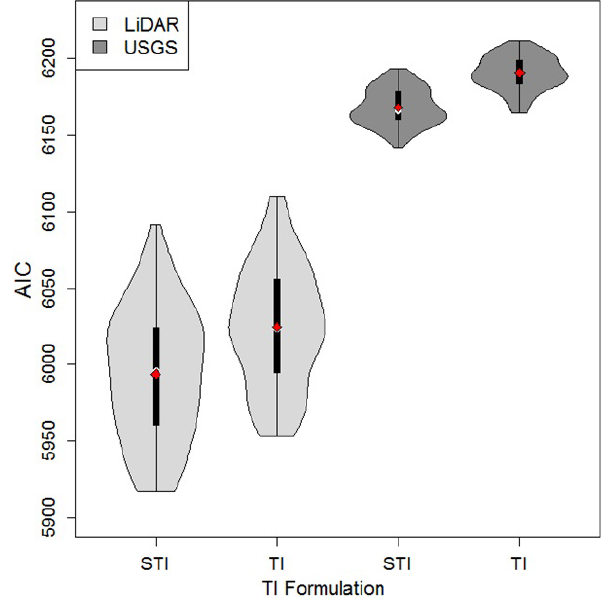
Figure 3. Violin plot of AIC values vs. TI form for the lidar and USGS data sets. Mean and median values are depicted as red dia- monds and white dots,